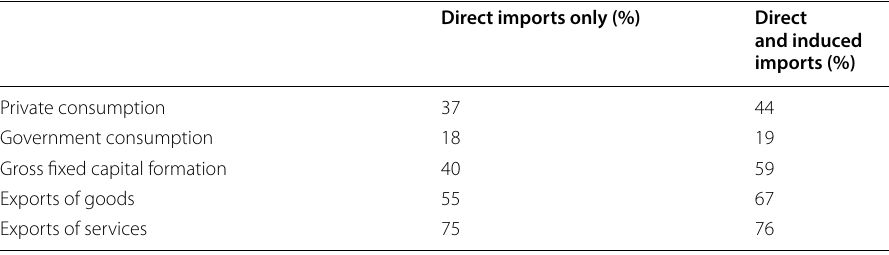
Table 2 Comparison of import content estimates for Malta’s GDP